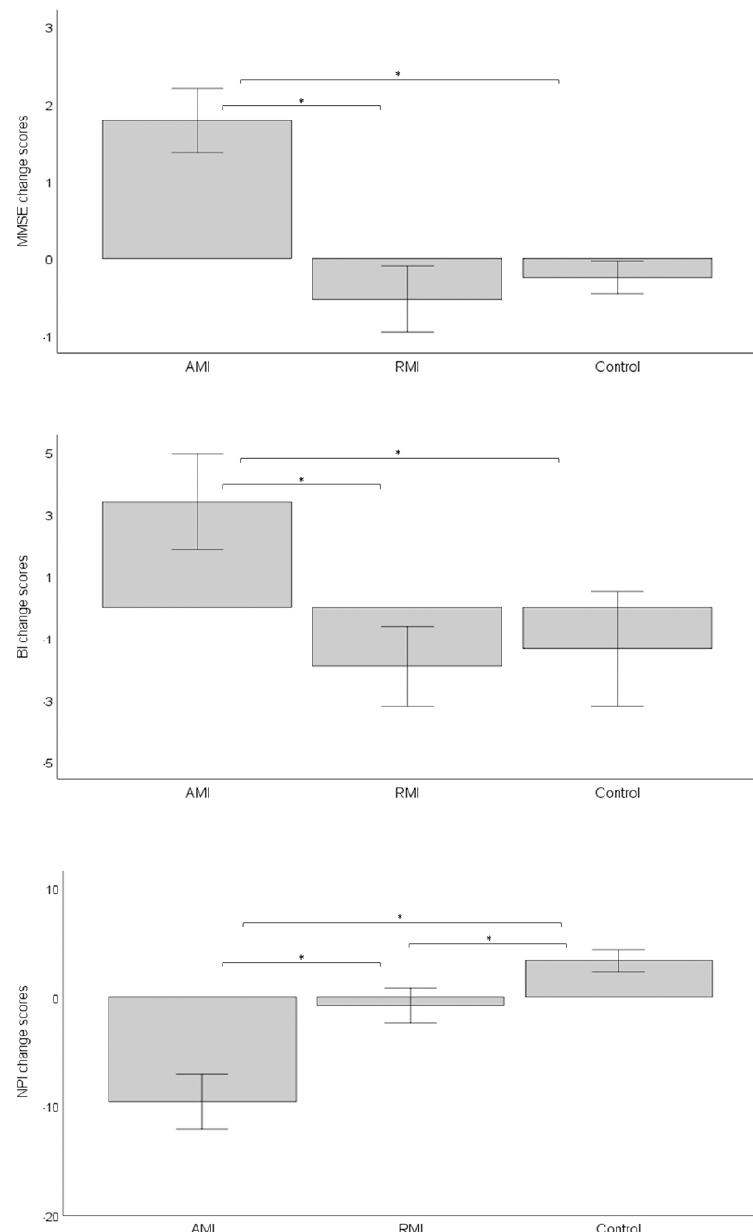
Figure 1. Graphical representation of the change in MMSE, NPI, and BI scores by group. AMI, active music intervention; BI, Barthel index; MMSE, Mini Examination of the Mental State; NPI, Neuropsychiatric Inventory; RMI, receptive music intervention. Bars represent standard error * p < 0.001 in post hoc comparison after one-way ANCOVA.